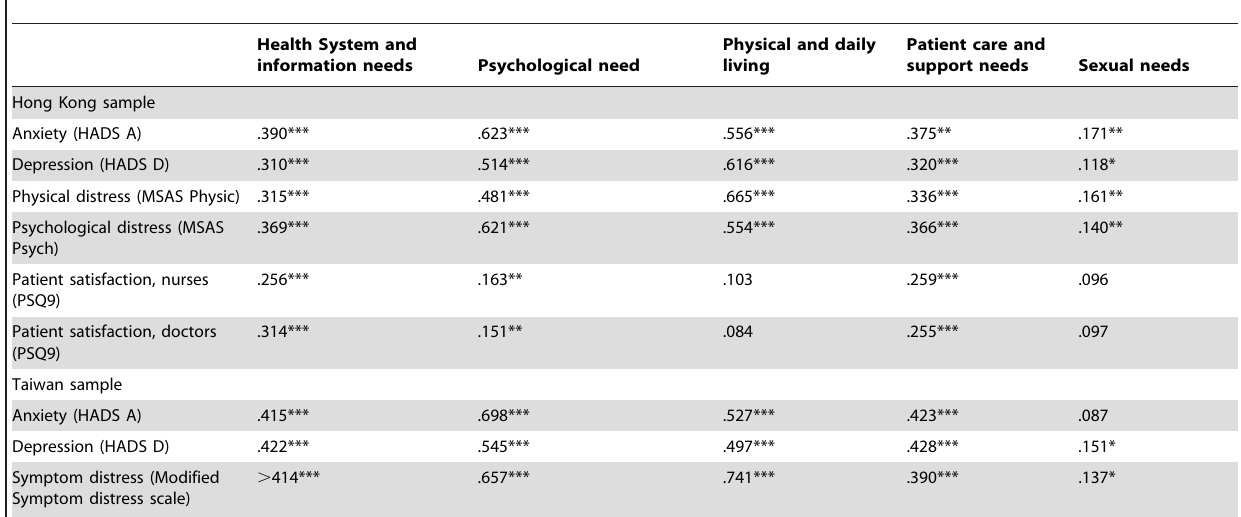
Table 5. SCNS-SF34 5-factor model domains and anxiety, depression, symptom distress, patient satisfaction with clinical staffs and optimism, Pearson’s correlation.